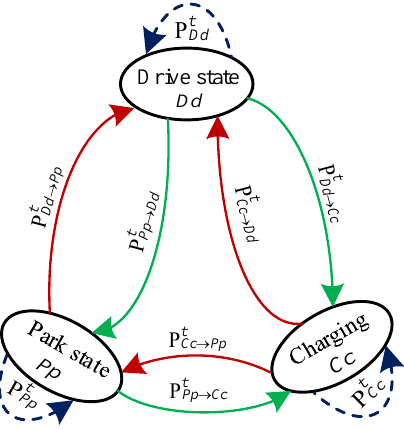
Figure 3. Transition probability of EV